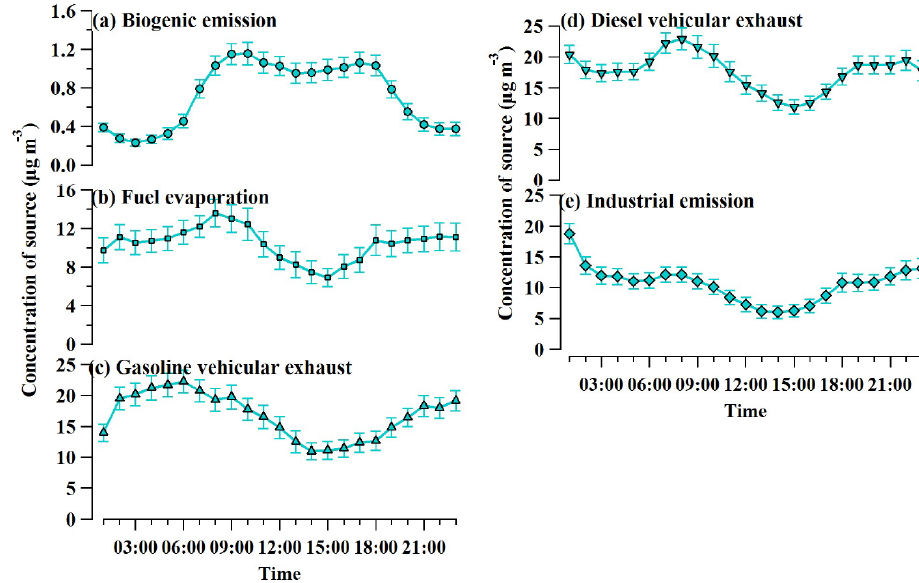
Figure 5. Diurnal patterns in source concentrations of the five identified sources.